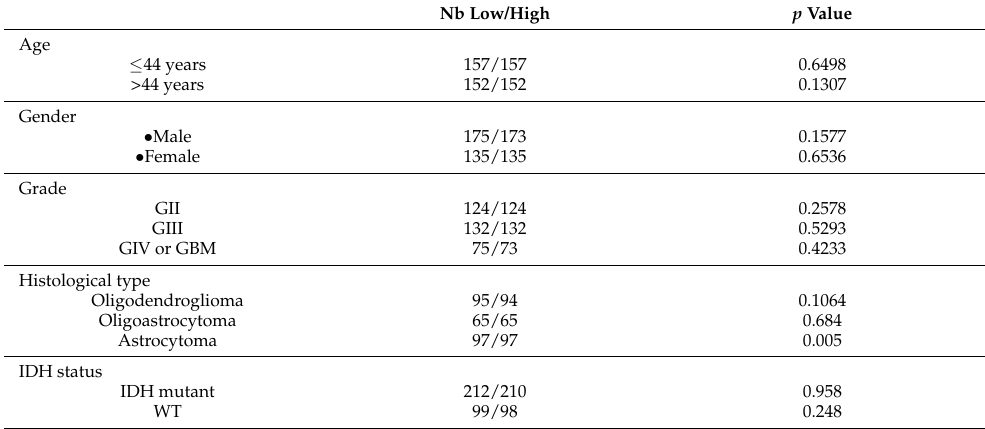
Table 5. A 2A R gene expression was associated with good prognosis in TCGA astrocytoma patients.